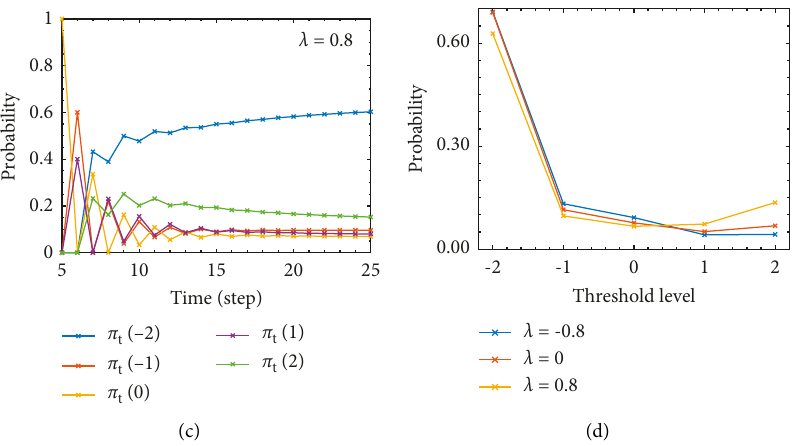
Figure 6: (a–c) The time evolution of the probabilities that occupy each of the threshold levels. The reward probabilities are given by ( P A , P B ) � (0.9, 0.7). The autocorrelation coefficient λ is configured differently: (a) λ � − 0.8, (b) λ � 0, and (c) λ � 0.8. (d) Comparison of the probabilities occupying threshold level with different autocorrelation coefficients at t �